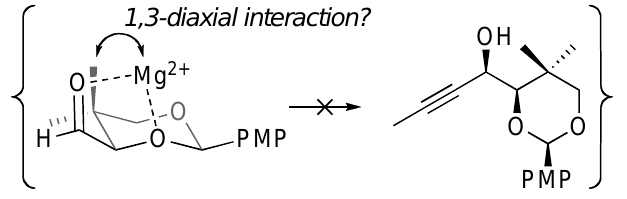
Figure 4. A diaxial interaction that may disrupt chelation in aldehyde